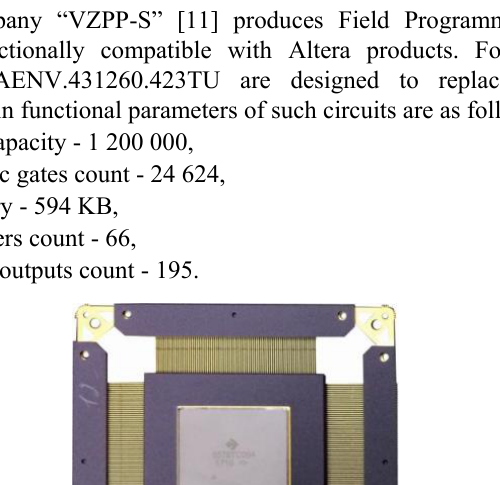
Fig. 2. 1508АС015 IC and evaluation board [10].